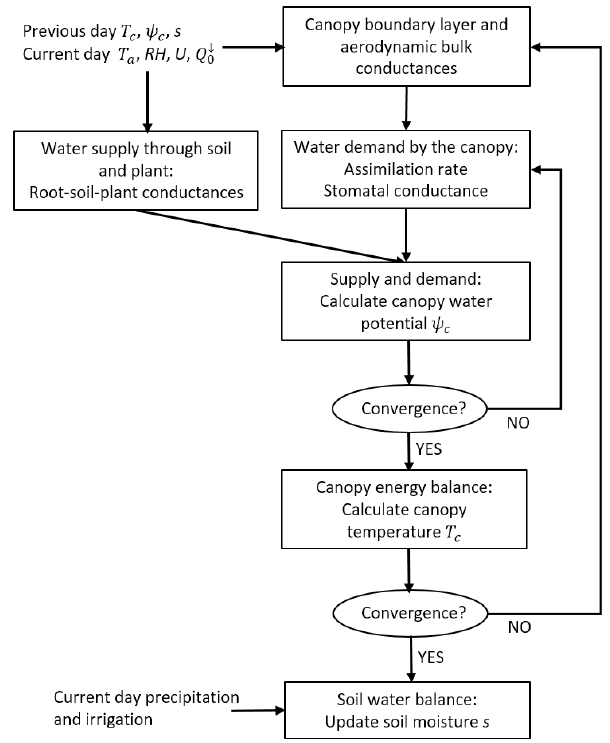
Figure 1. Flow diagram of the determination of canopy temperature and soil moisture